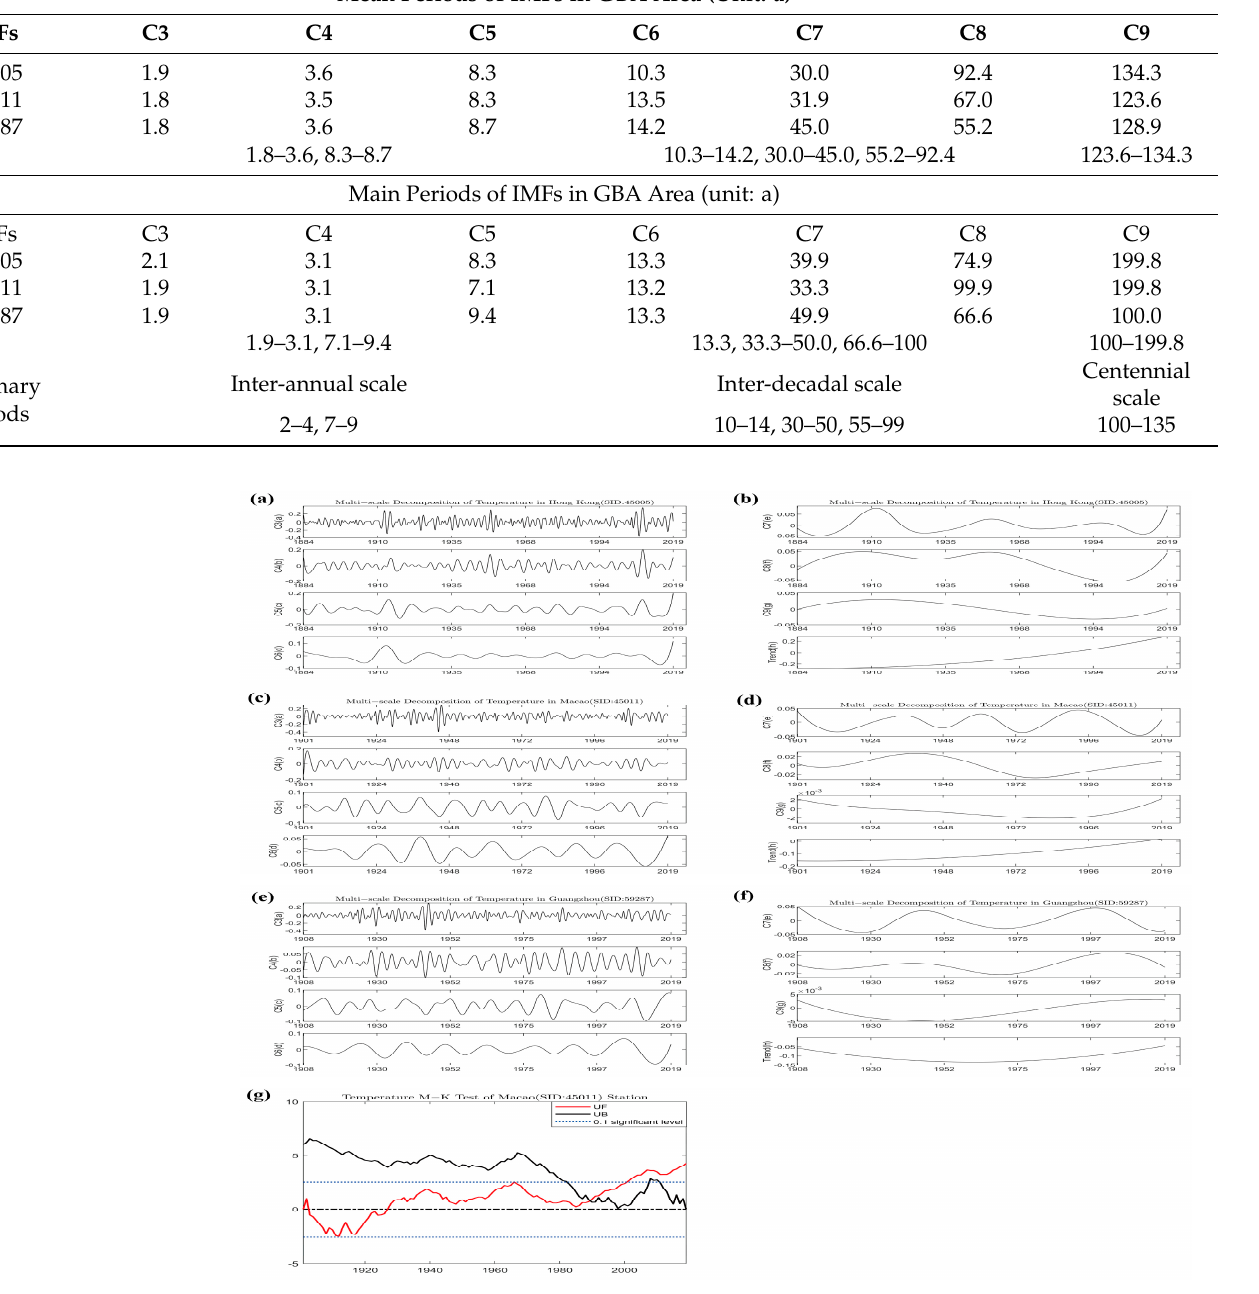
Figure 6. IMFs and trend of mean monthly temperature in Hong Kong ( a , b ), Macao ( c , d ), and Guangzhou station ( e , f ) and temperature M-K test of Macao station ( g ). Table 7 provides multi-scales of fluctuation with timescales of more than one year of pre- cipitation in the GBA. C4 - C6 represent inter-annual scales with mean periods of 2.4–5.0 and 8.7–9.3 a and main periods of 2.5–3.4 and 6.0–6.7 a. C7 - C8 show inter-decadal scales